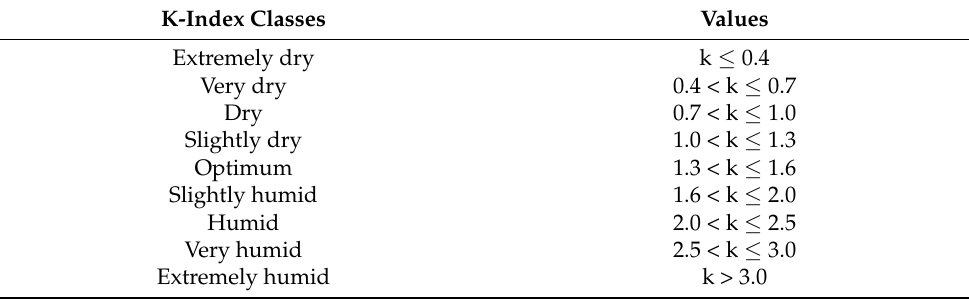
Table 1. Classes of the Sielianinow’s hydrothermal